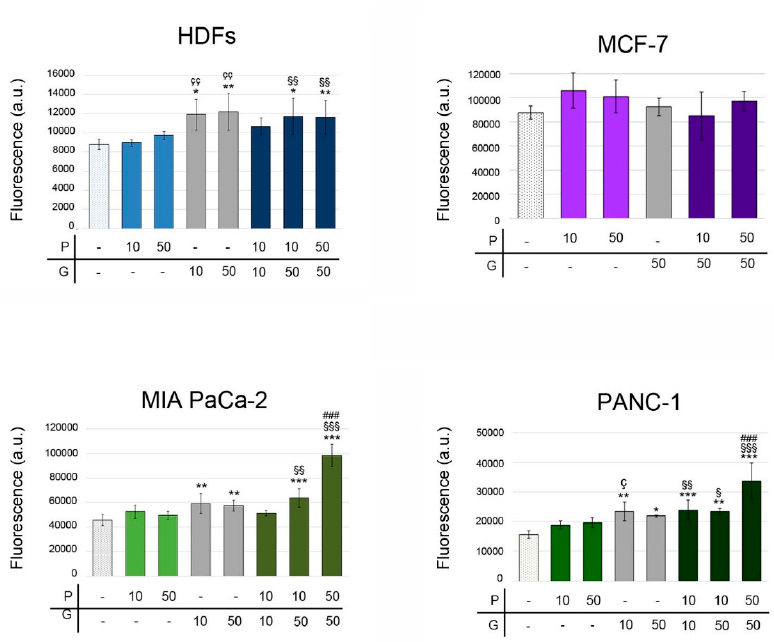
Figure 5. Impact of PRO/GEM treatments on intracellular ROS levels on MIA PaCa-2, PANC-1, MCF-7 cells and HDFs. The values of fluorescence intensity ± SD after PRO/GEM treatments are reported. The symbols denote statistical significance: *, any treatment versus control; ç, GEM versus the corresponding concentration of PRO; §, #, PRO/GEM combinations versus the corresponding concentration of PRO or GEM, respectively. P = protopine; G = gemcitabine. *, §, ç p < 0.05; **, §§, çç p < 0.01; ***, §§§, ###, p < 0.001.